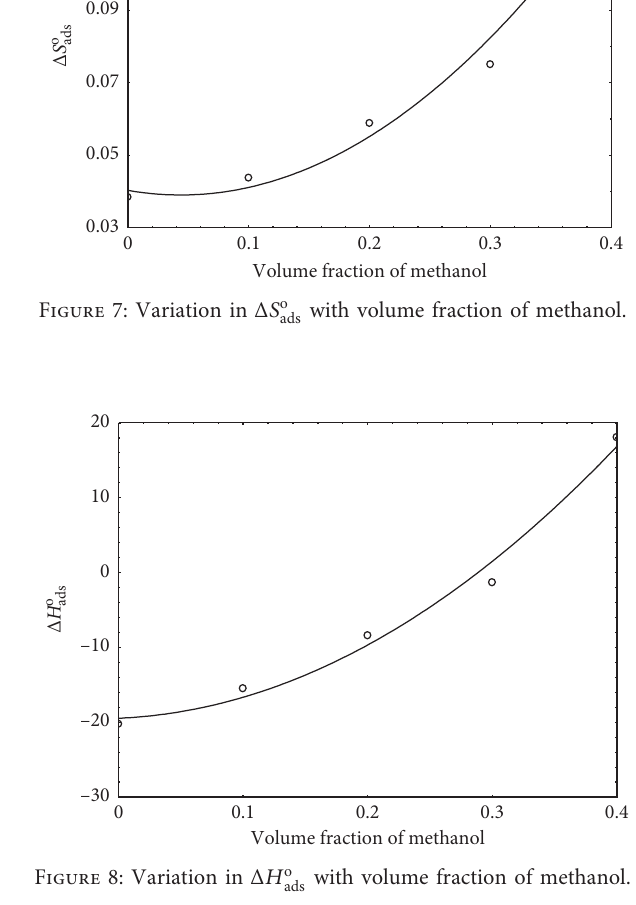
with volume fraction of ads